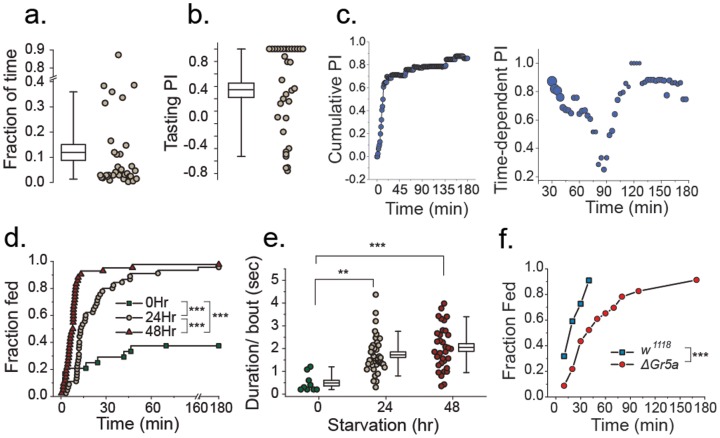
New types of behavioral inference from the FLIC system.(A) Flies spent 10% of their time in behaviors we categorized as tasting two foods prior to making their first meal choice. Fraction of time is calculated based on “total time spent tasting/time until the first meal”. (B) A greater fraction of tasting events were directed toward the food the flies choose to consume (mean Tasting PI = 0.35). A Tasting PI = 1 implies a fly tasted a single food before ultimately consuming that food. A Tasting PI = −1 implies that a fly tasted a single food before ultimately consuming the opposite food. (C) While a cumulative preference index (left panel) is effective at portraying overall feeding tendencies, time-dependent preference indices (right panel) reveal subtle differences in behavioral choices as the experiment progresses. Flies exhibited a strong preference toward 10% sucrose in the first 30 min, which was attenuated in later time periods then returned to a strong preference (N = 34; the size of the symbol is proportional to the sample size contributed to calculate PI in a given period). (D) Flies with increased feeding motivation (through longer periods of starvation) experienced their first meal earlier than control flies. Flies starved for increasing periods (0 hr, 24 hr, or 48 hr) exhibited reduced latencies until their first feeding event. Latency curves were found to be significantly different via log-rank test. (E) Flies with increased hunger (through longer periods of starvation) exhibited meals that were of significantly longer duration than control flies (One-way ANOVA followed by post-hoc test using a Bonferroni correction). (F) Taste input plays a role in motivation by decreasing latency to the first meal. Flies with loss of function in the trehalose receptor, ΔGr5a, were significantly delayed in their first meal of a liquid trehalose food compared with control animals (log-rank test). **P≤0.01; ***P≤0.001